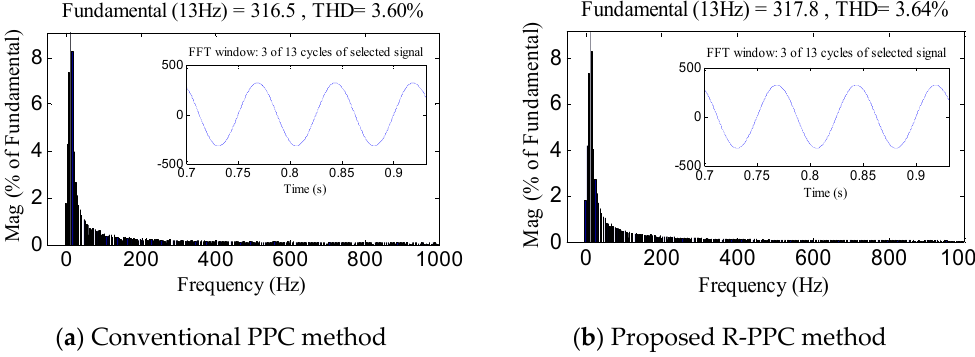
Figure 15. Stator current frequency spectra of the 6*3-phase PMSM under the discharge state. ( a ) Conventional PPC method; ( b ) Proposed R-PPC method.